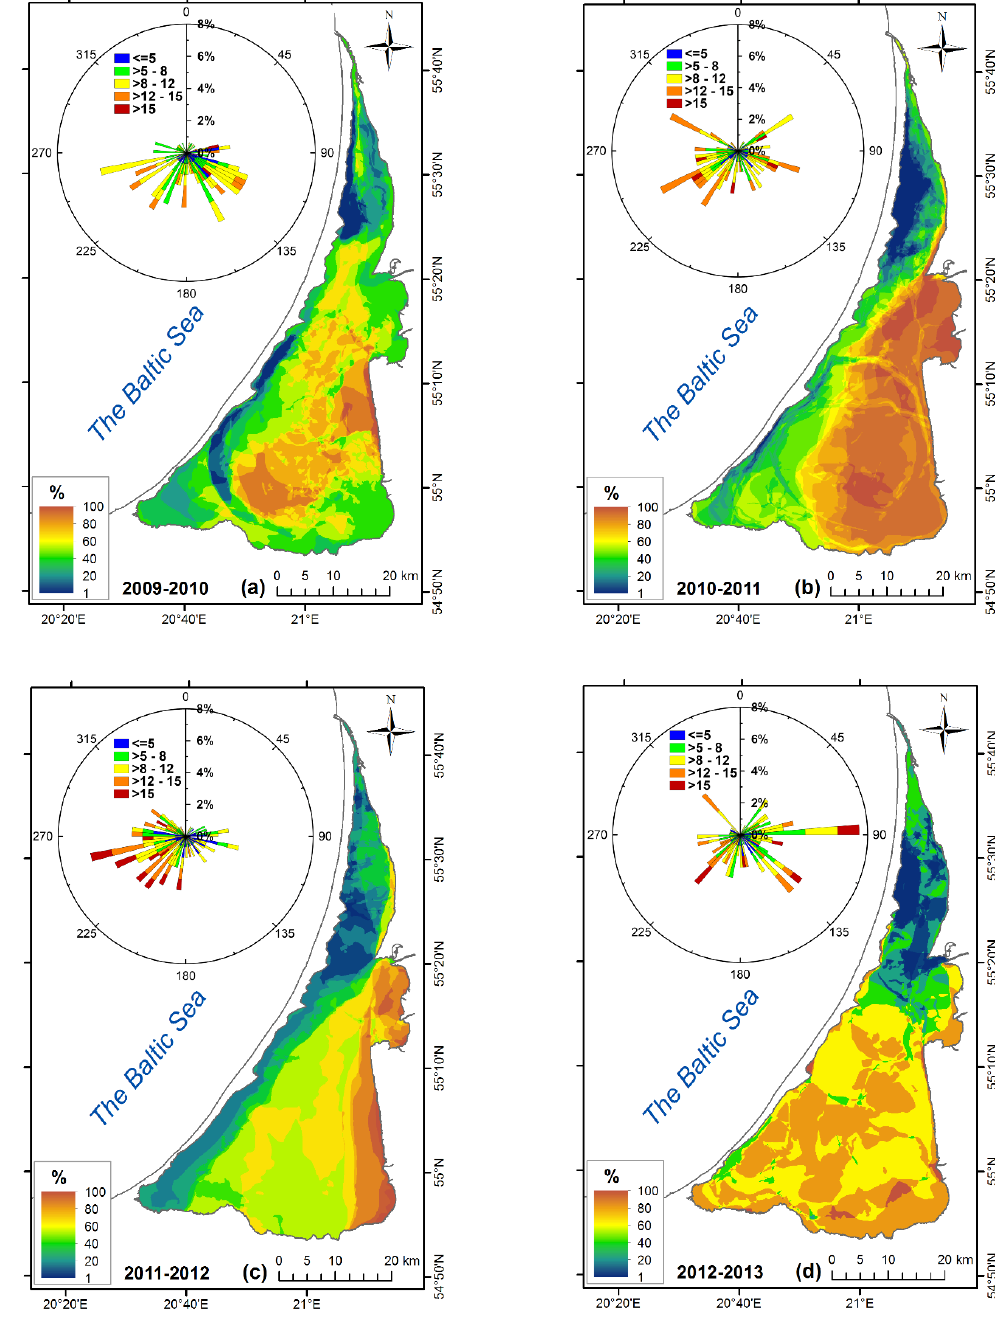
Figure 9. Probability of ice cover observations (%) in the Curonian Lagoon according to spaceborne SAR data in: ( a ) 2009–2010; ( b ) 2010–2011; ( c ) 2011–2012; ( d ) 2012–2013. Inserts show wind roses for the period from 20 November to 15 April.